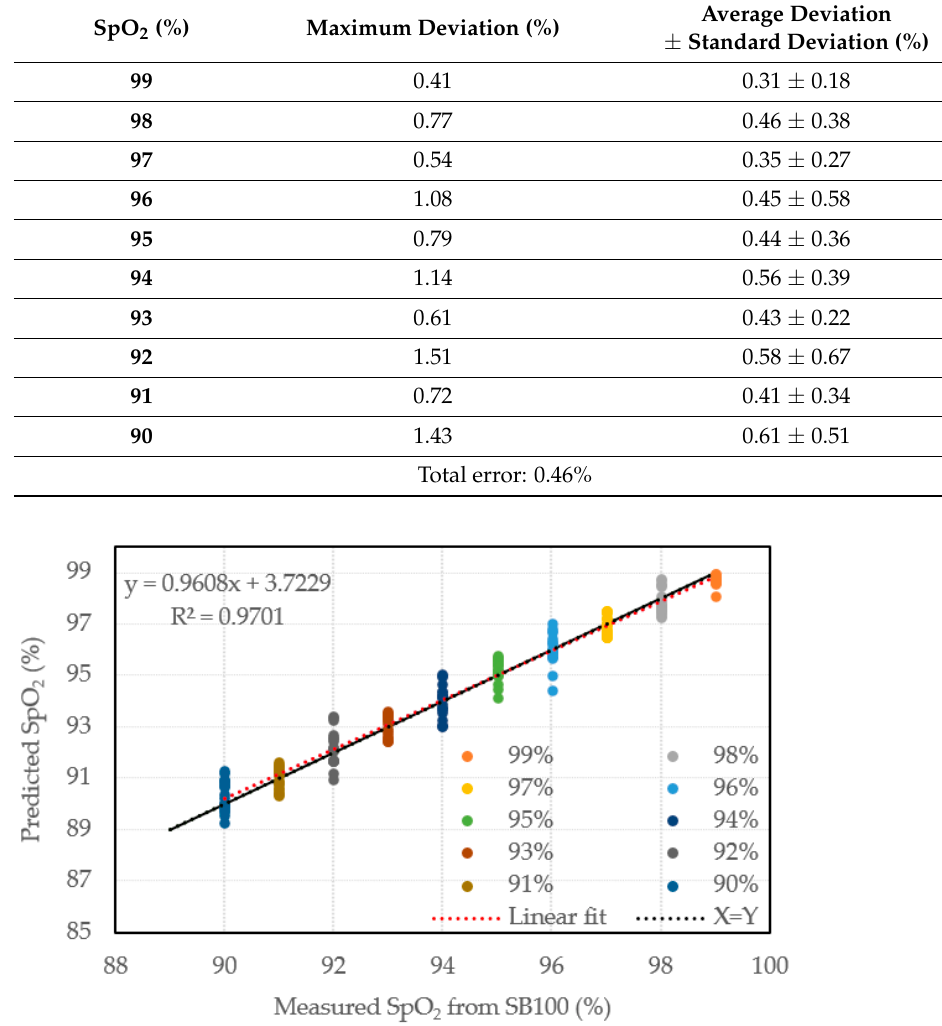
Figure 12. Standard calibration of SB100 and predicted SpO 2 of proposed